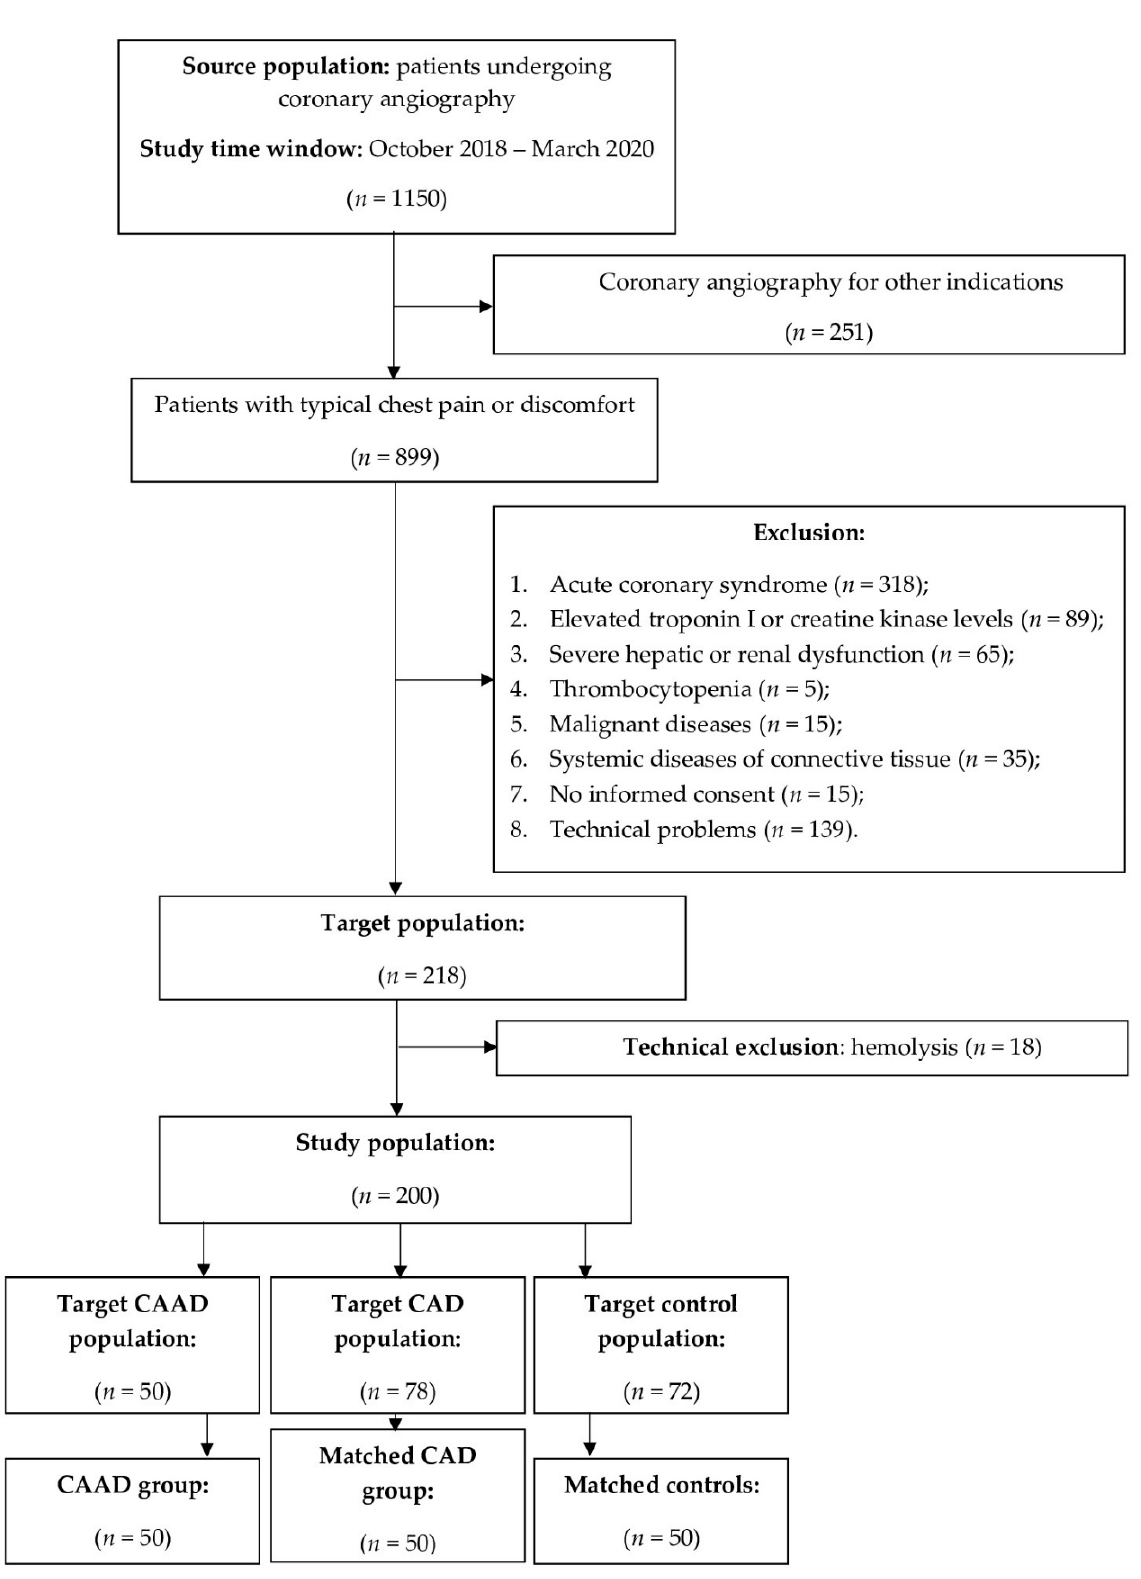
Figure 1. Flowchart of the study population. Inclusion and exclusion criteria for the study cohort and selection process for the coronary artery abnormal dilation (CAAD) group, coronary artery disease (CAD) group, and normal coronary arteries (NCA, control) group.